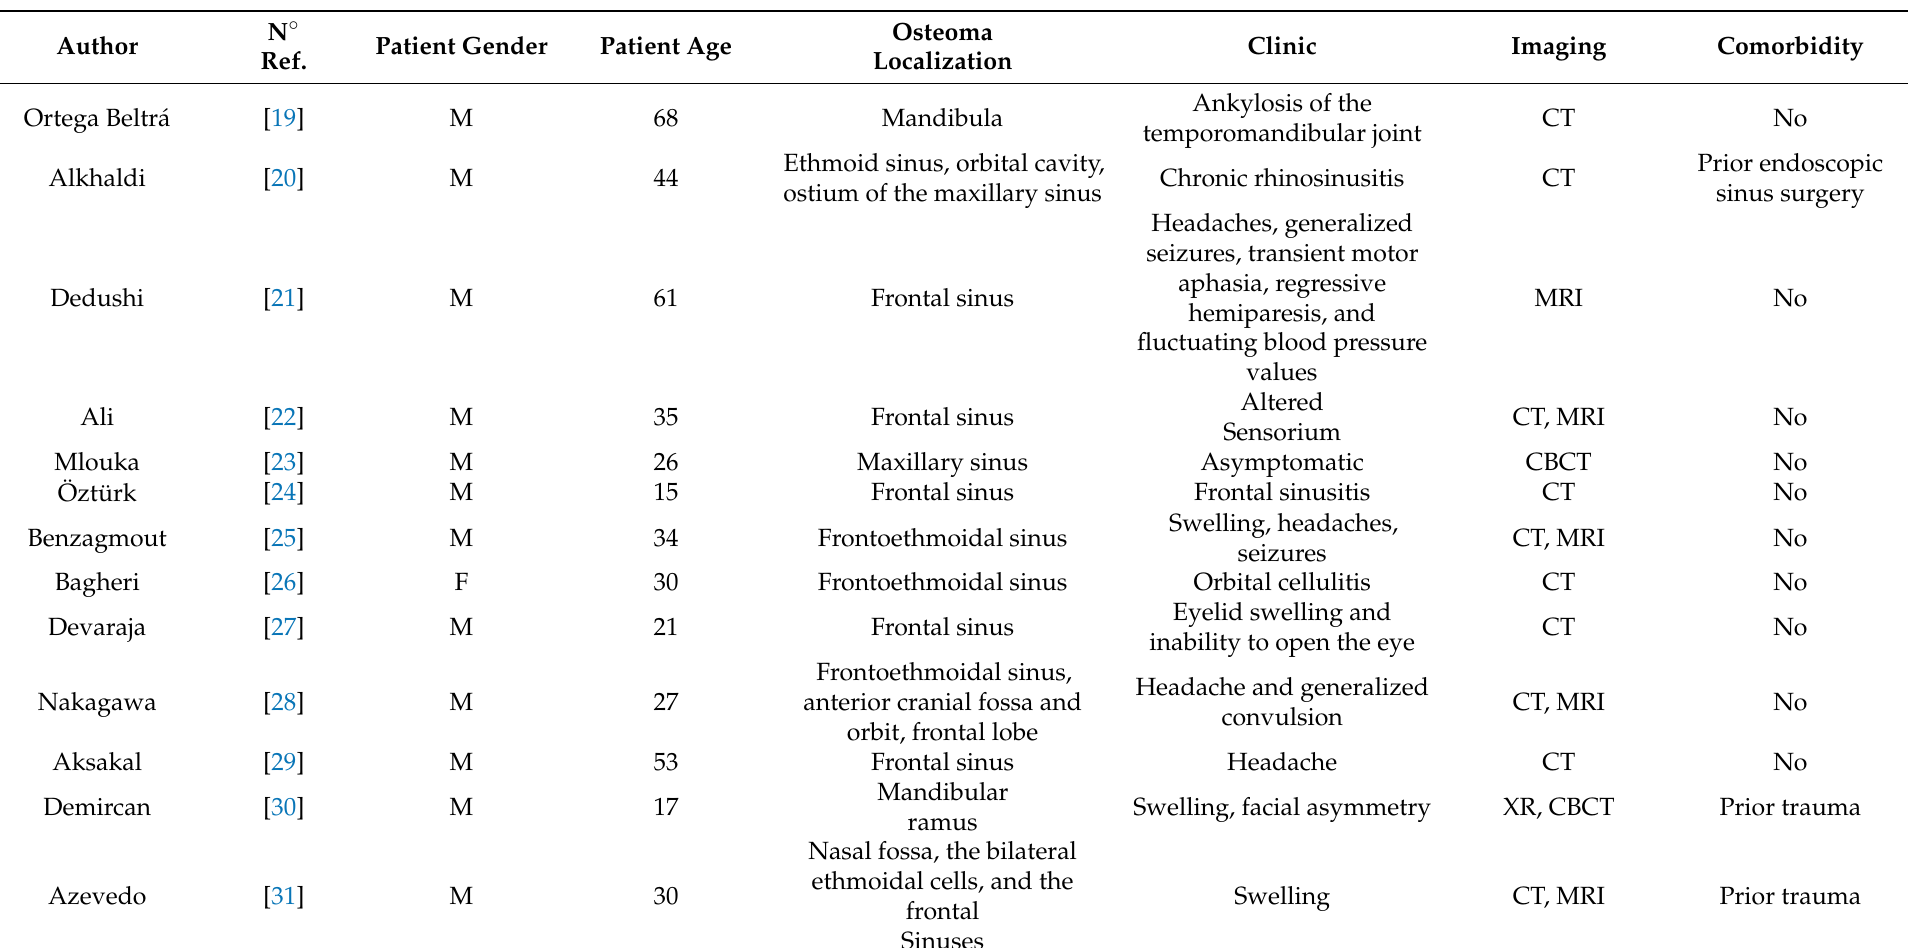
Table 1. Literature review of the cases of solitary craniofacial osteomas reported from January 2020 to September 2021, with descriptions of clinical and diagnostic features. (F) female; (M) male; (CT) computed tomography; (CBCT) cone beam CT; (XR) radiography; (MRI) magnetic resonance